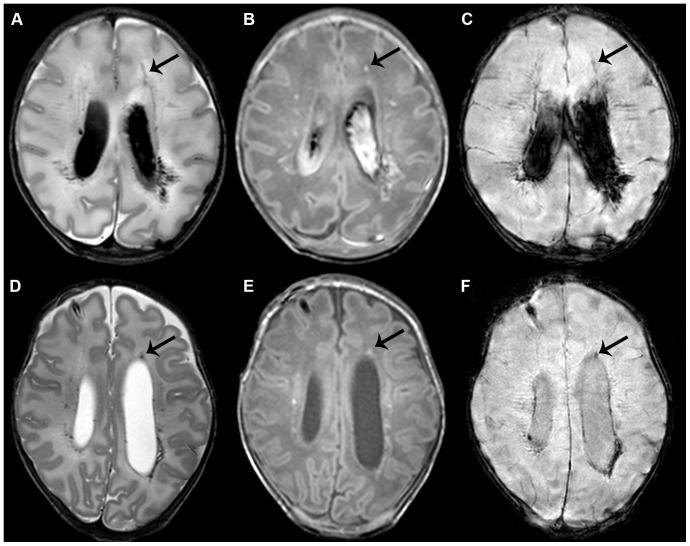
Punctate white matter lesions with a linear pattern.Early (A–C) and term equivalent (D–F) scans in an infant of 32 weeks gestation with lesions in a mixed, though mainly linear pattern. T2-weighted imaging shows bilateral lesions in the white matter adjacent to the ventricles (A). Lesions are also visible on T1-weighted imaging, additionally showing a small subdural hemorrhage (B). The arrow indicates one of the lesions, visible on all images. Also note the grade III intraventricular hemorrhage. SWI shows signal loss in the areas of the lesions, suggestive of a hemorrhagic origin (C). Additionally, some small frontal lesions can be identified, that do not show up on SWI, and show a cluster appearance. At term equivalent age, lesion load has greatly diminished and the intraventricular hemorrhage has largely resolved on T2- and T1-weighted imaging (D, E). A subcutaneous reservoir has been inserted to treat post-hemorrhagic ventricular dilatation. SWI still shows signal loss with blood residue being most clearly visible on this sequence (F). Outcome was favorable with a cognitive composite score of 115 and a total motor composite score of 124 on the Bayley scales at two years corrected age.